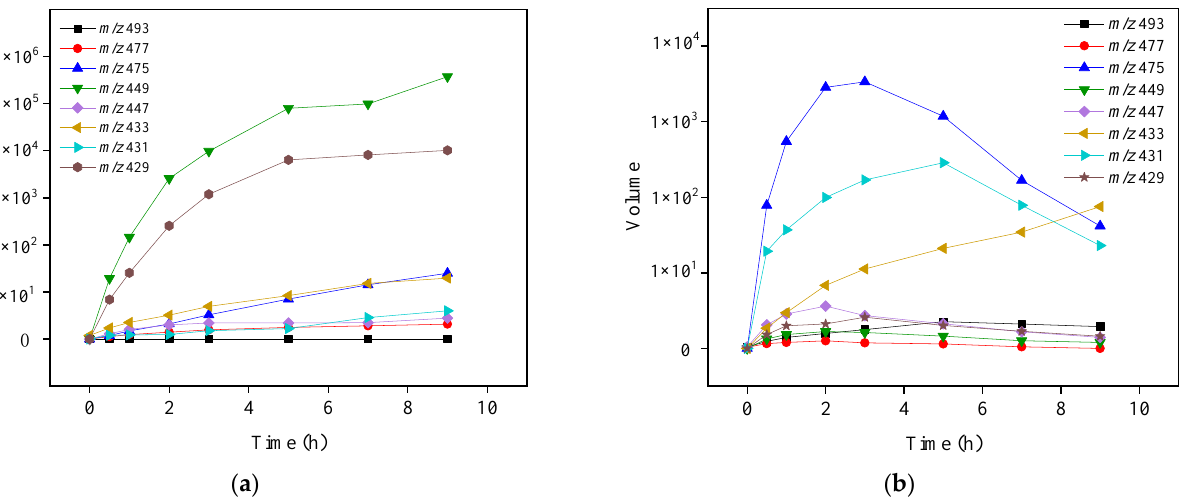
Figure 8. Evolutions of OTC transformation products by photolysis ( a ) and TiO 2 -assisted photosensitized degradation ( b ) under visible light irradiation at pH 8.6. Experimental conditions: [OTC] 0 = 10 mg L − 1 , [TiO 2 ] 0 = 0.5 g L − 1 , 50 mM phosphate